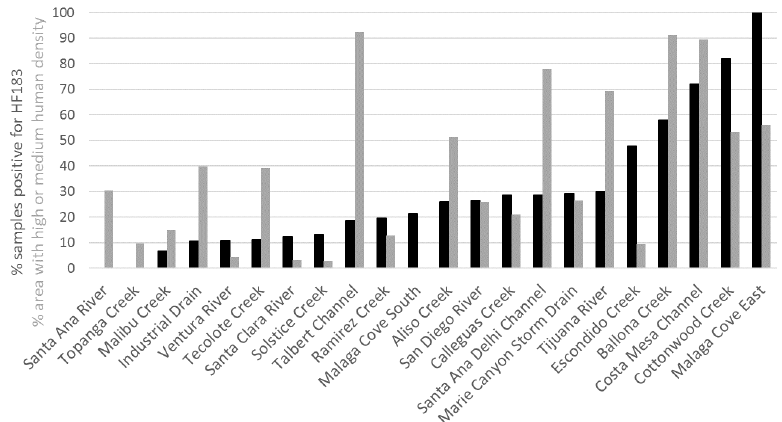
Figure A3. Frequency of HF183 detection in the drainages during dry weather conditions (black bars) and percentage area with high or medium human density in the watershed where the drainage is located (gray bars). Frequency of HF183 detection is defined as % samples that are positive for HF183, and a sample is deemed HF183 positive if HF183 is amplified in any of the three qPCR replicates. Sites are sorted from left to right by frequency of HF183 positives.